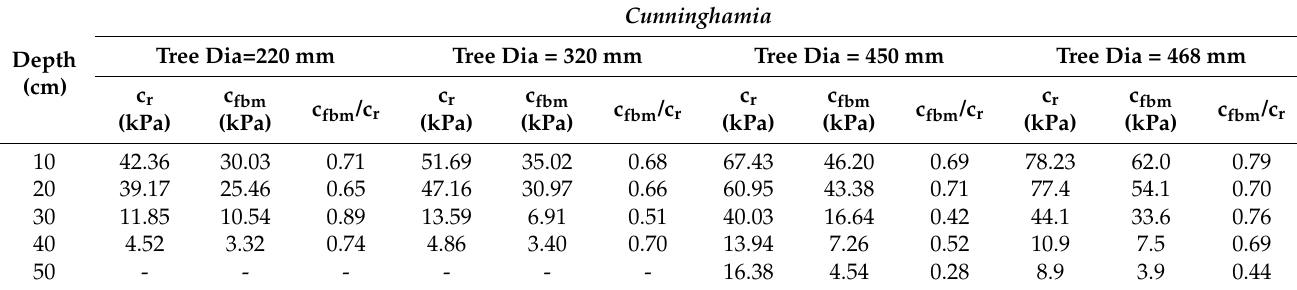
Table 6. Roots cohesion values for investigated species and ratio between WWM and FBM.